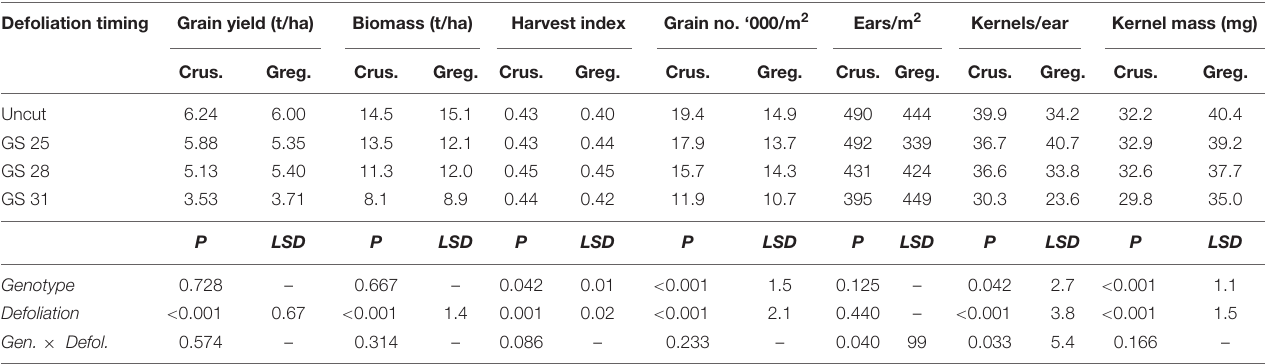
P-score (P) for main effects of genotype, defoliation treatment and the interaction are provided below and least significant difference (LSD at P = 0.05) for these effects when they are significant.